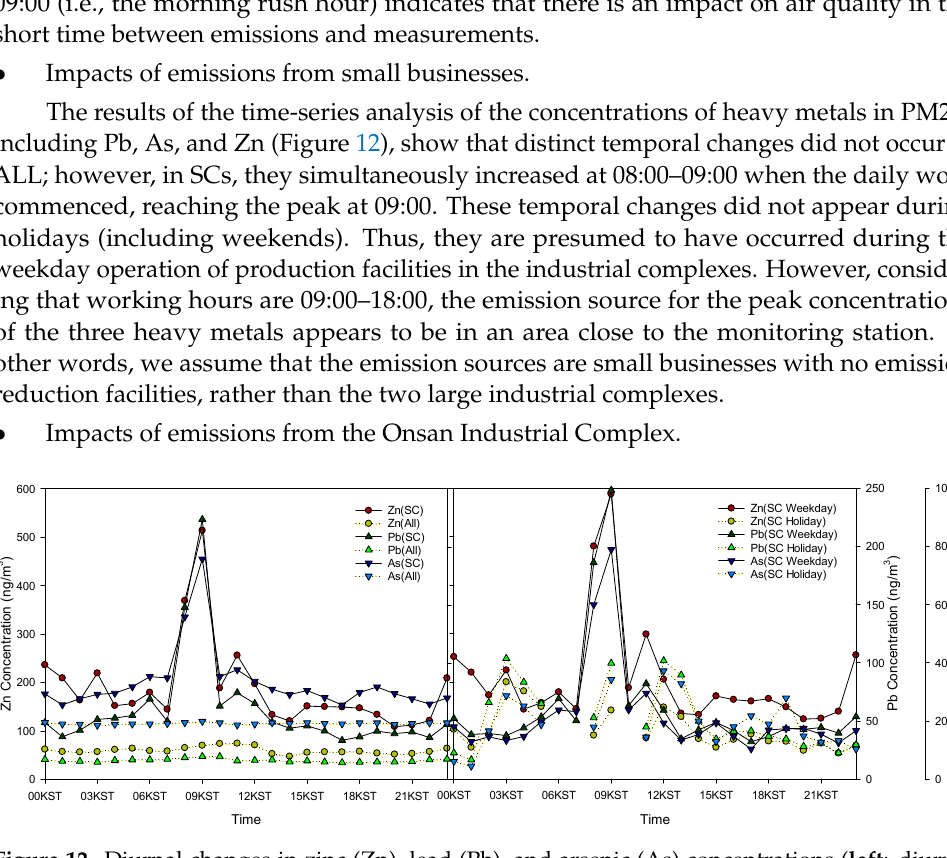
Figure 11. Diurnal changes in the ratio of OC to EC, the concentrations of OC and EC, and the cor- relation between OC and EC ( left : ALL, right : SCs).